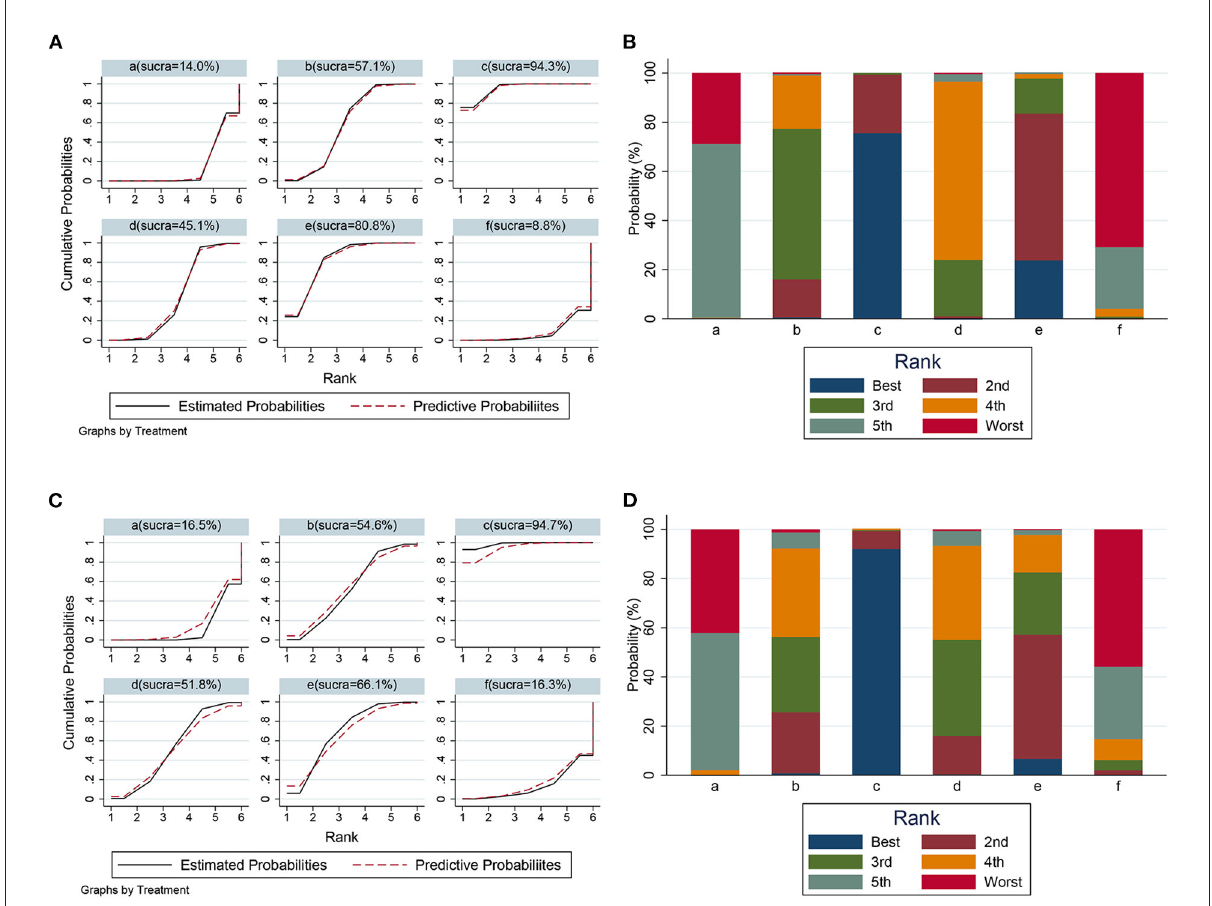
FIGURE7 The SUCRA value and probabilities of each treatment doses. (A) SUCRA value ranking of different administration doses according to data on 28th day. (B) Histogram of ranking probability of each treatment dose according to data on 28th day. (C) SUCRA value ranking of different administration doses according to data on 21th day. (D) Histogram of ranking probability of each treatment dose according to data on 21th day. a, control; b, 10 mg/kg metformin; c, 50 mg/kg metformin; d, 100 mg/kg metformin, e, 200 mg/kg metformin; f, 320 mg/kg